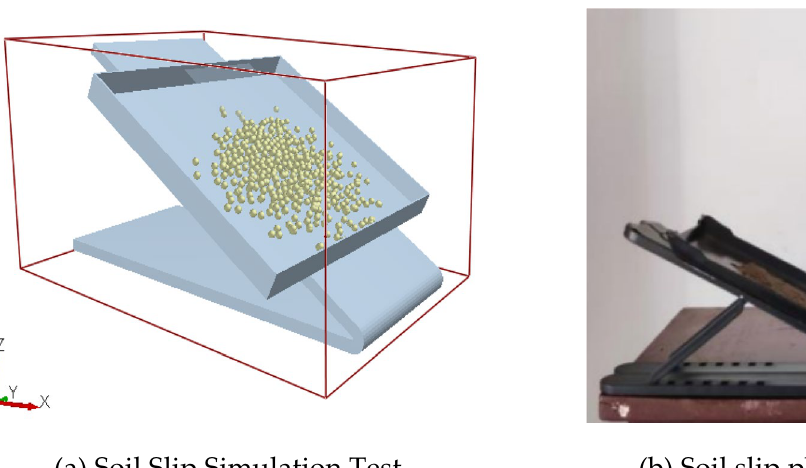
Figure 6. Soil slip test.